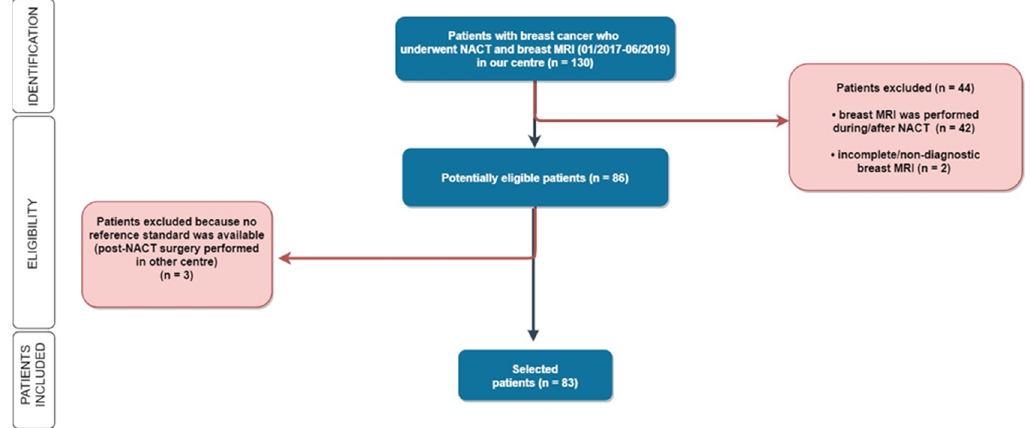
Figure 1. Flowchart. Out of 130 women enrolled in our study, 46 patients were subsequently excluded for the following reasons: for 40 patients the MRI was not performed before the chemotherapy but during or after NACT; for 4 patients the MRI was not technically adequate (1 due to lack of contrast medium administration, 2 due to movement artifacts, 1 due to interrupted examination); and 3 patients underwent post-NACT surgery in another hospital. MRI = magnetic resonance imaging; NACT = NACT: neoadjuvant chemotherapy .